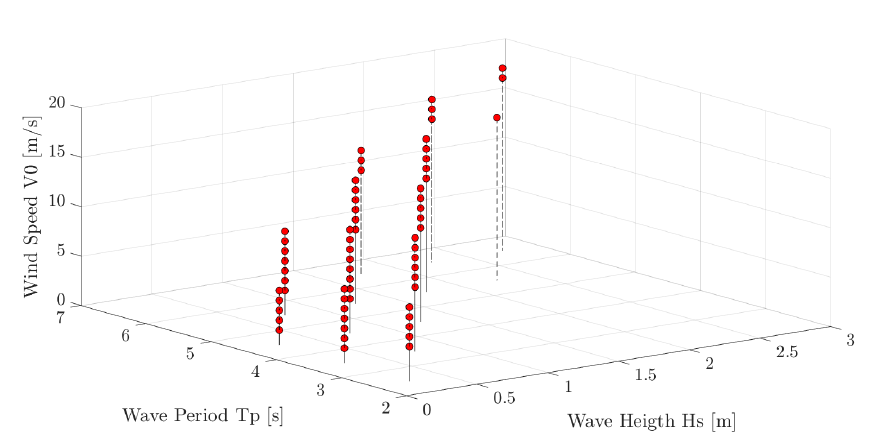
Figure 13. Graphical distribution of the 63 selected